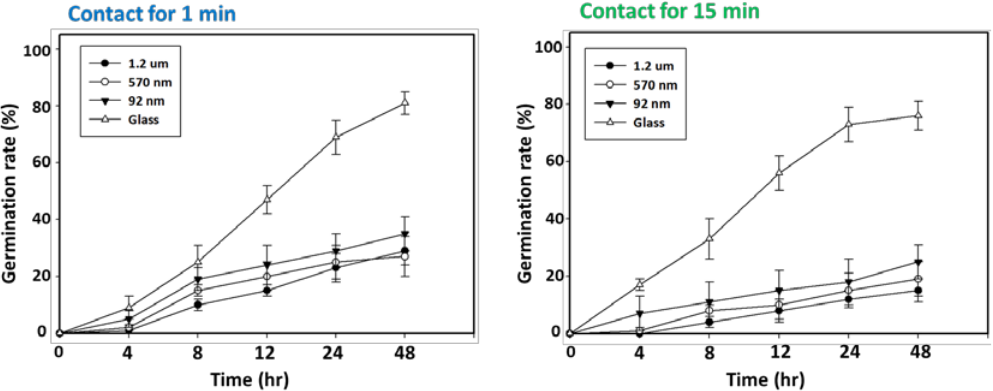
Figure 5. Spore germination rate of C. gloeosporioides for different Ag particle sizes and contact times.